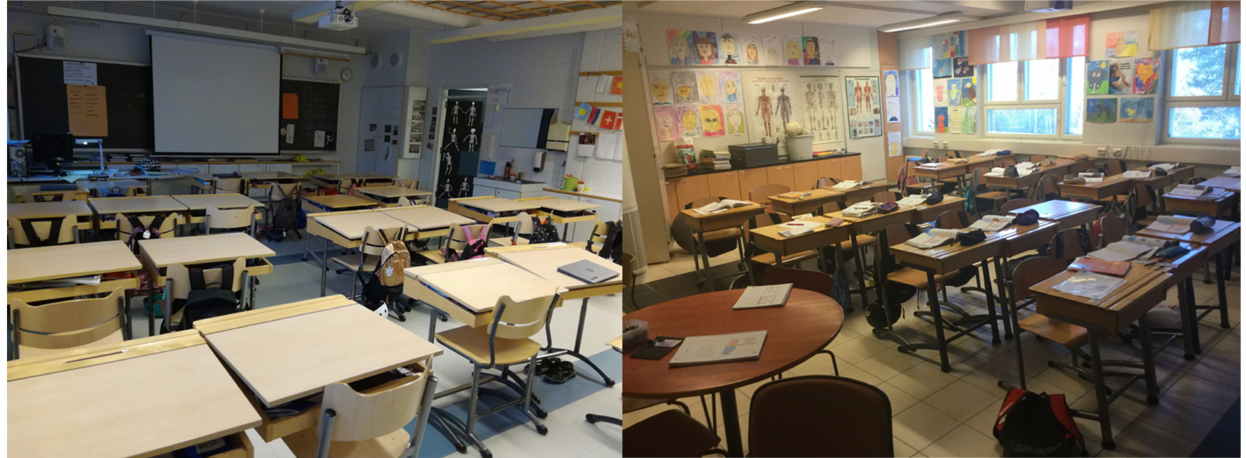
Figure 2. Pictures of the conventional classrooms represent typical, smaller, self-contained rooms for around 20 students with a designated desk for each